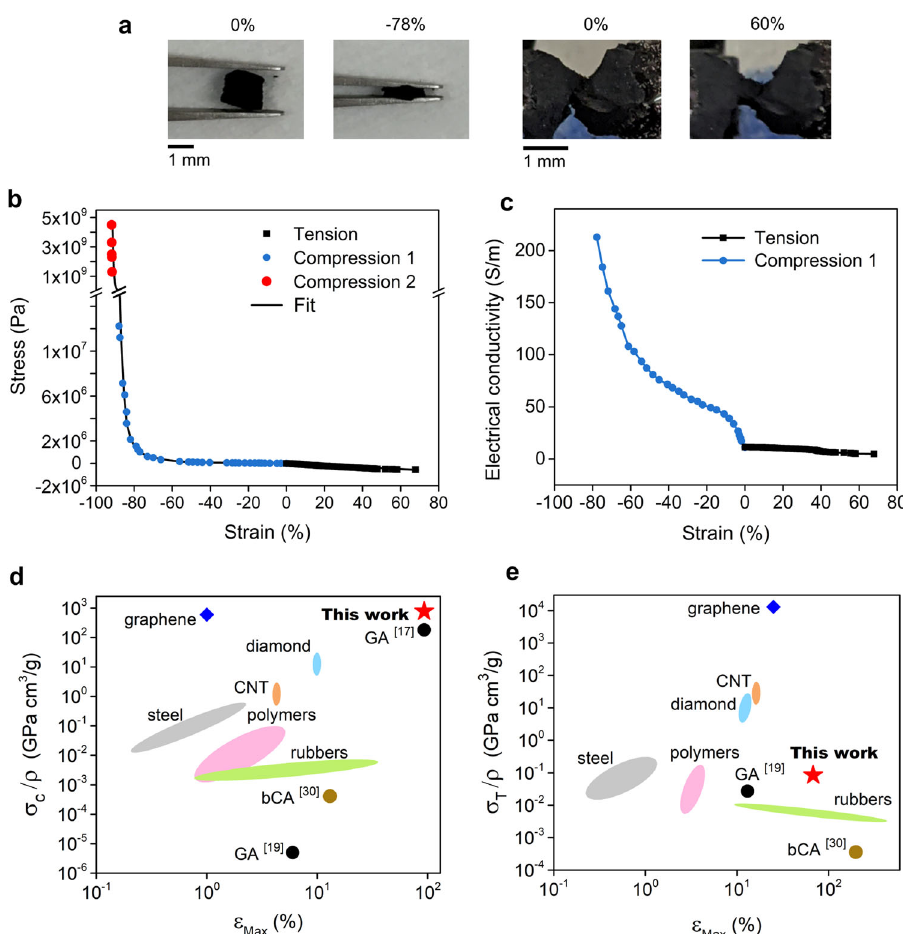
Fig. 2 Mechanical and electrical properties of graphene aerogels. a Optical image of macroscopic samples under compressive ( − 78%) and tensile (60%) strain. The positive and negative strain is used to distinguish between tensile and compressive deformation, respectively. b Compressive and tensile stress-strain curves of graphene aerogel. The negative stress depicts the opposite direction to the applied pressure. Each point represents an average of N = 10 experiments. Error bars are smaller than the symbol size, see Methods Mechanical testing for full statistics. c Electrical conductivity as a function of compressive (negative) and tensile (positive) strain. d , e Comparison of compressive 44 – 49 ( d ) and tensile 50 – 55 ( e ) speci fi c yield strength of different materials (graphene aerogels (GA) 17,19 , binary carbon aerogels (bCA) 29 , graphene 45,51 , diamond 46,52 , CNT 47,53 , stainless steel 48,54 , polymers 49,55 , and elastomers 36,50 ) as a function of the maximum elastic